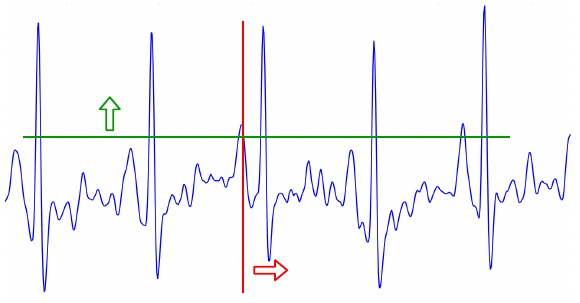
Figure 4. Horizontal scanning (green line) vs vertical scanning (red line). Arrows represent the direction of the scanning